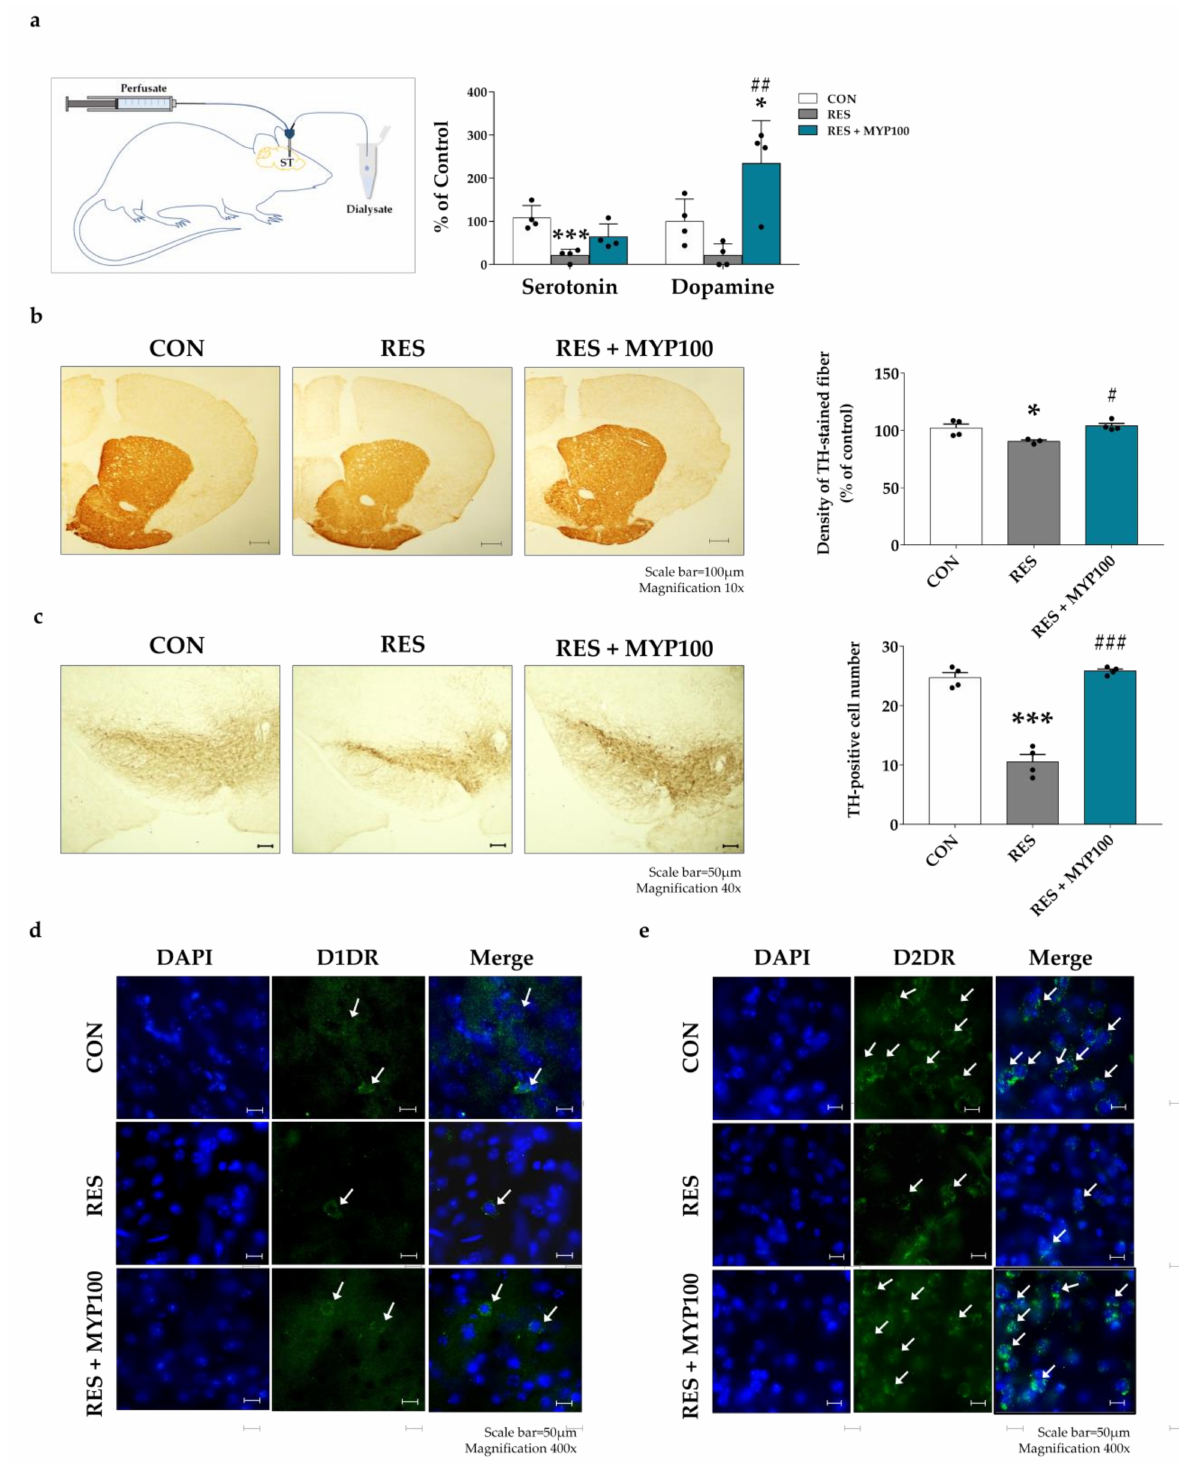
Figure 11. Change in serotonin and dopamine release and the expression of dopamine-related factors in the striatum (ST) following myelophil (MYP) treatment. ( a ) Serotonin and dopamine levels were increased after 100 mg/kg